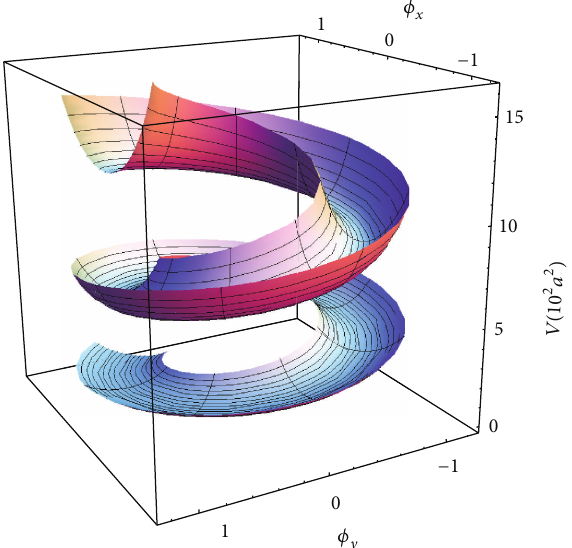
Figure 1: The helicoid structure of potential (13) scaled by 10 2 𝑎 2 . In the graph, parameters 𝑏 and Λ are set to be 𝑏 = 0.1 and Λ = 1 ,